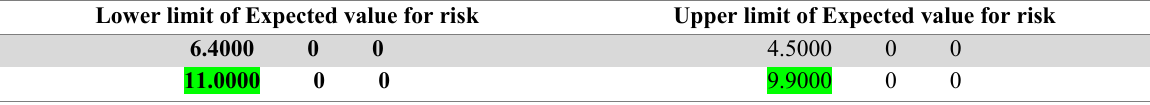
Upper and Lower Limit of Expected Value for Risks Lower limit of Expected value for risk Upper limit of Expected value for